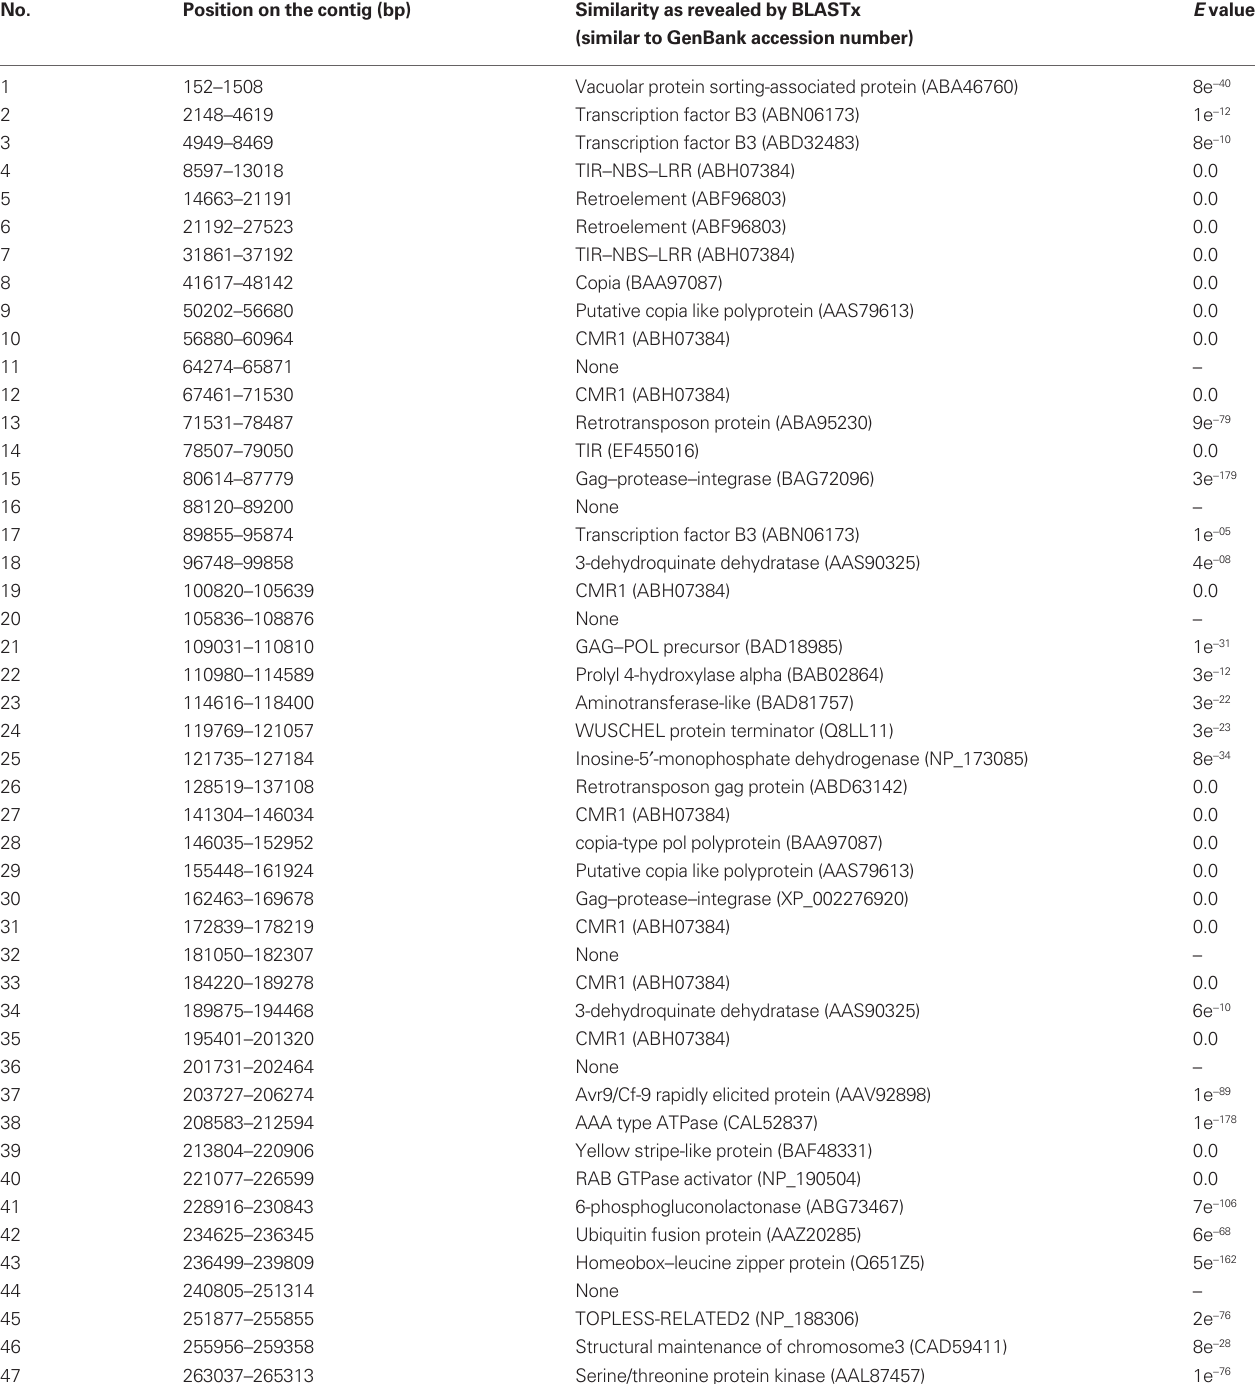
Table 1 | List of putative genes on the 265,477-bp contig around the Rdr1 locus in the R. multiflora genotype as determined by FgeNeSH and geNSCAN a